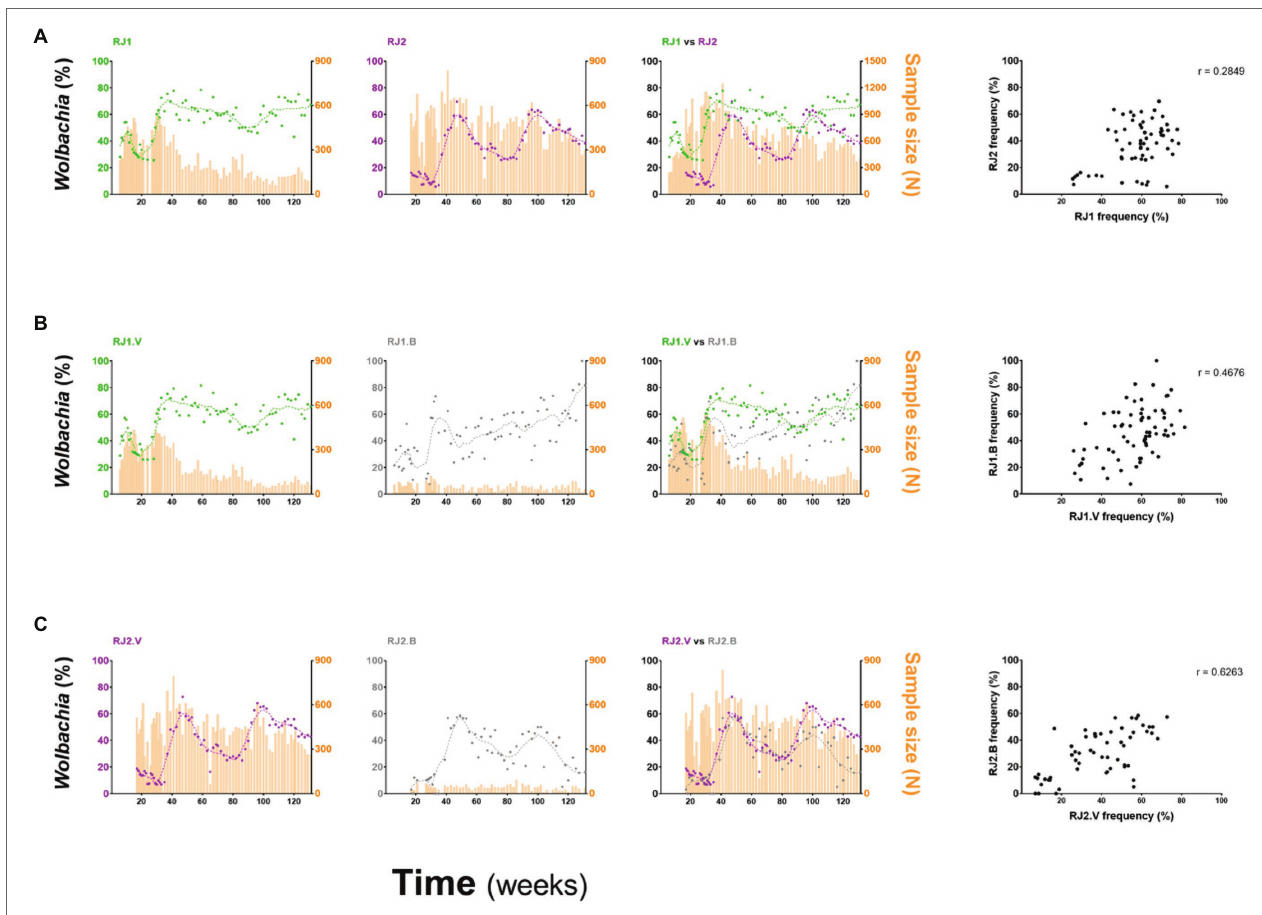
FIGURE 4 | Comparison of invasion profiles between intervention areas and deployment strategies. w Mel frequencies for different intervention areas, or deployment strategies, were represented individually and overlayed and compared by Spearman’s correlation analyses. (A) RJ1 vs. RJ2; (B) RJ1.V vs. RJ1.B; and (C) RJ2.V vs. RJ2.B. The degree of association between frequency datasets is indicated by the r coefficient, at the top right of the correlation